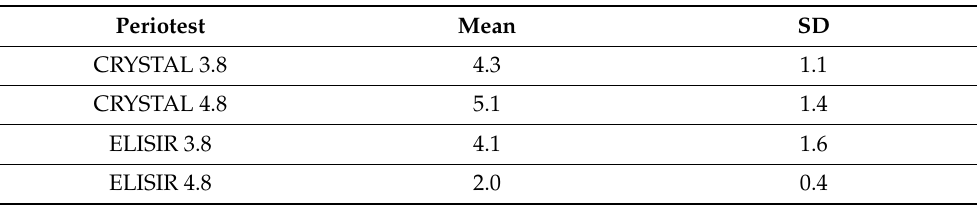
Table 5. Summary of the Periotest means for the study groups.